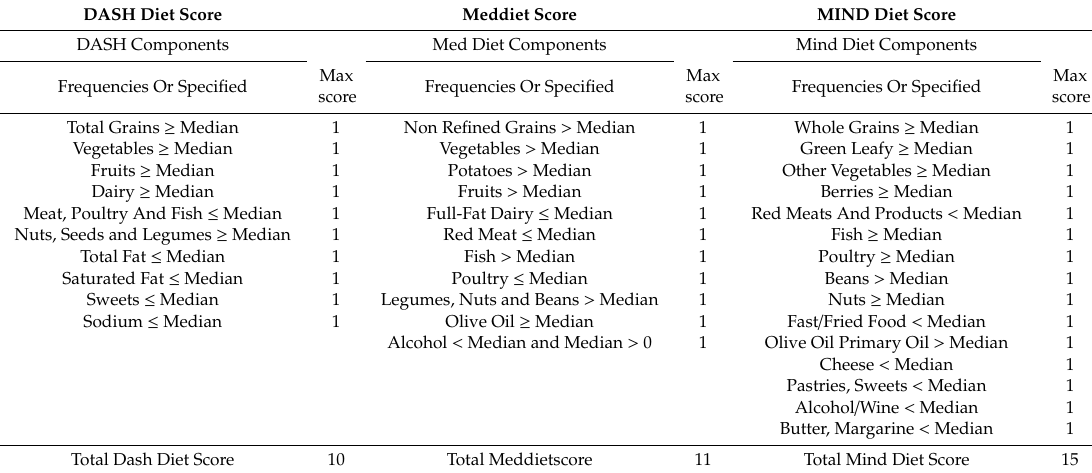
Table 1. The scoring algorithms of the DASH diet score, Meddietscore and MIND diet